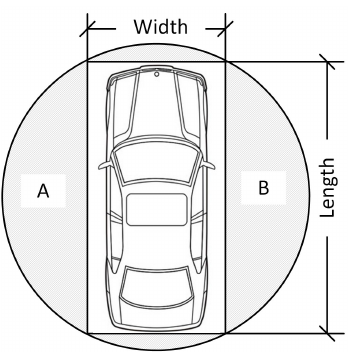
Figure 1. Comparison of modelling a rigid-body as its smallest circumcircle and a rectangle with length and